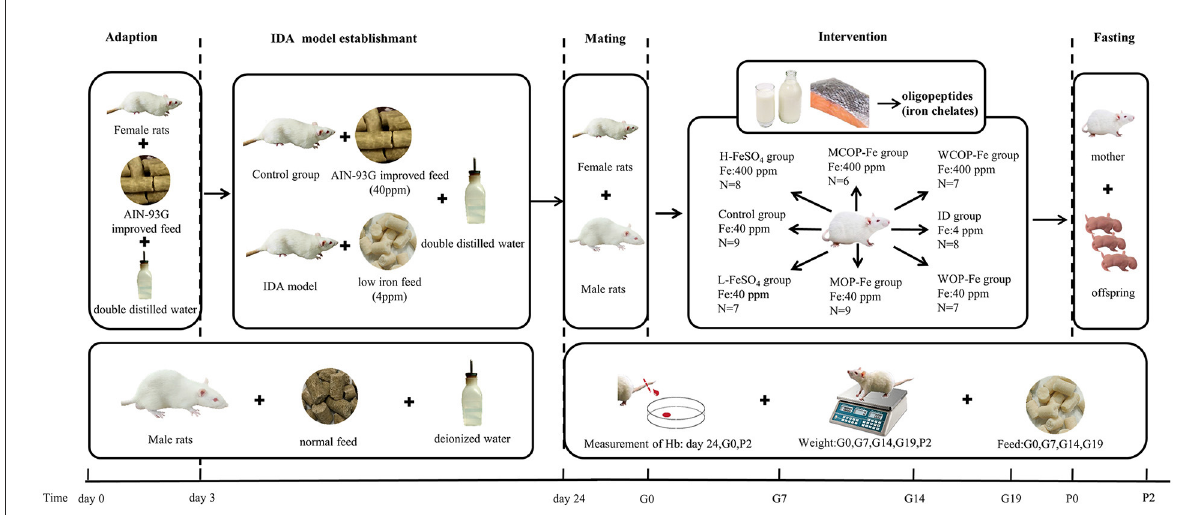
FIGURE1 Scheme of IDA model establishment and iron intervention. IDA, iron deficiency anemia; Hb, Hemoglobin; ID, iron deficiency anemia model group (4 ppm FeSO 4 ); H-FeSO 4 , 400 ppm FeSO 4 ; L-FeSO 4 , 40 ppm FeSO 4 ; MCOP-Fe, 400 ppm marine fish oligopeptide iron complex; MOP-Fe, 40 ppm marine fish oligopeptide iron complex; WCOP-Fe, 400 ppm whey protein oligopeptide iron complex; WOP-Fe, 40 ppm whey protein oligopeptide iron complex; G0, the day of pregnancy; G7, the Seventh day of pregnancy; G14, the 14th day of pregnancy; G19, the 19th day of pregnancy; P0, the day of delivery; P2, the second day after